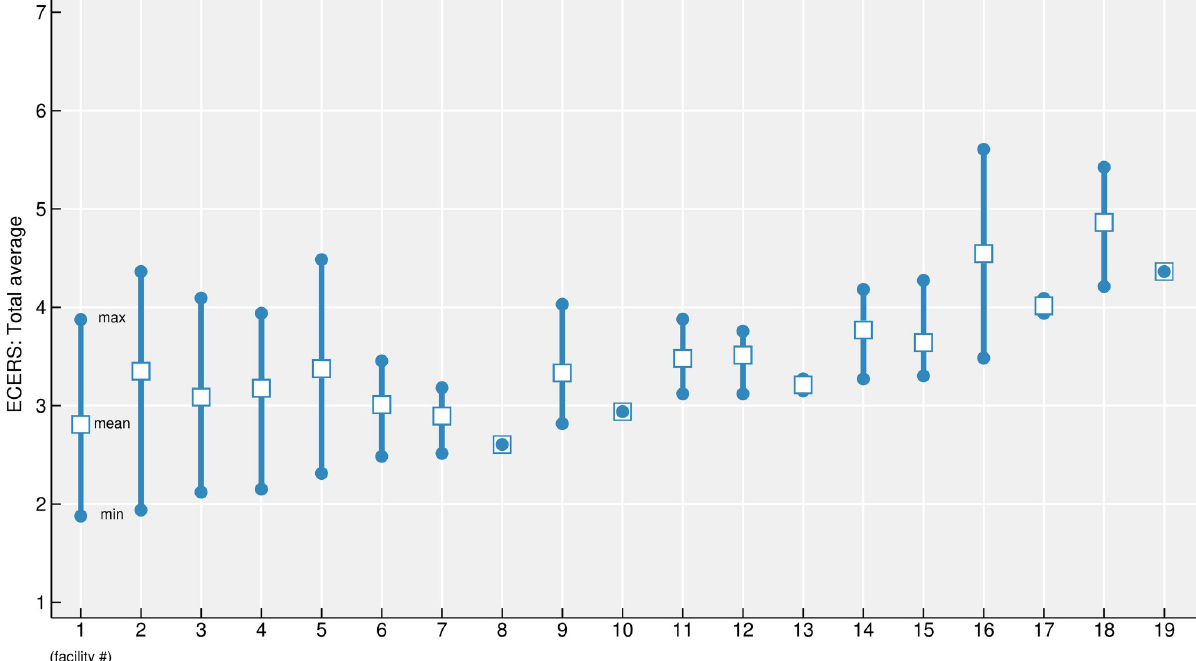
Fig 1. ECERS total average scores for each facility. Fig 1 shows the lowest and highest scores for each facility. These findings are important to visually examine the differences in scores within a facility.